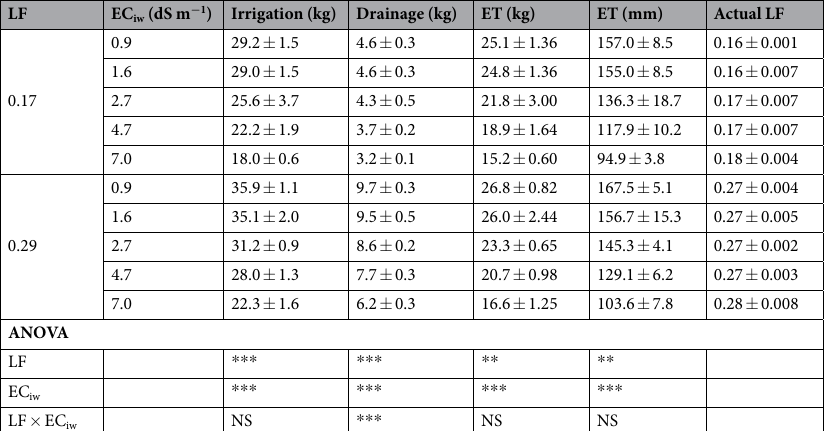
LF EC iw (dS m − 1 ) Irrigation (kg) Drainage (kg) ET (kg)